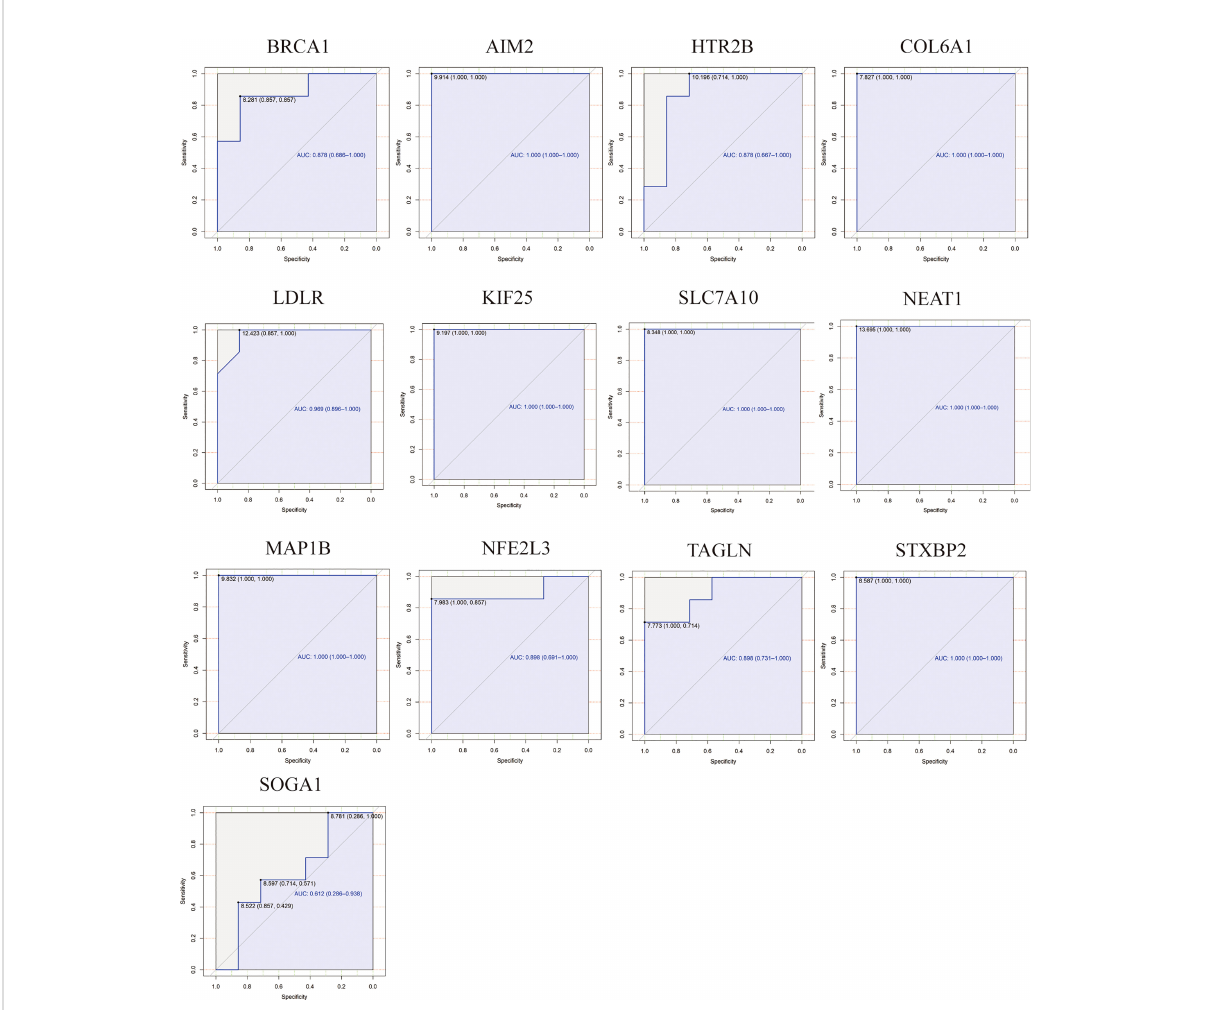
FIGURE 7 Receiver Operating Characteristic (ROC) and area under the curve (AUC) values analysis for hub ATGs. The speci fi city and sensitivity of the hub ATGs for the diagnosis of PCOS by the ROC analysis. AUC values exceeding 60% are considered to be acceptable, with 90% indicating higher sensitivity and speci fi